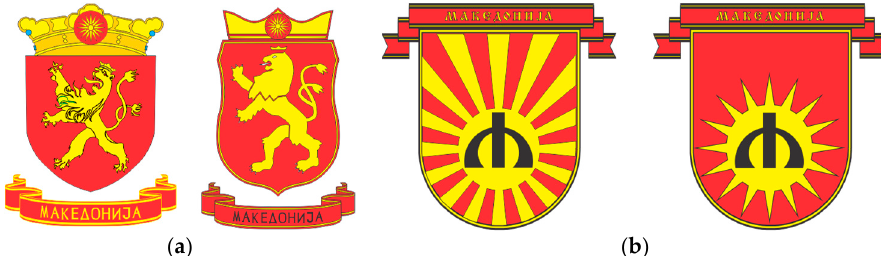
Figure 5. ( a ) Left : “Compromise” proposal by Todor Petrov, right : by Tomislav Stefkovski and Gjorgi Kotevski; ( b ) Proposals by Dimitar Dimitrovski.